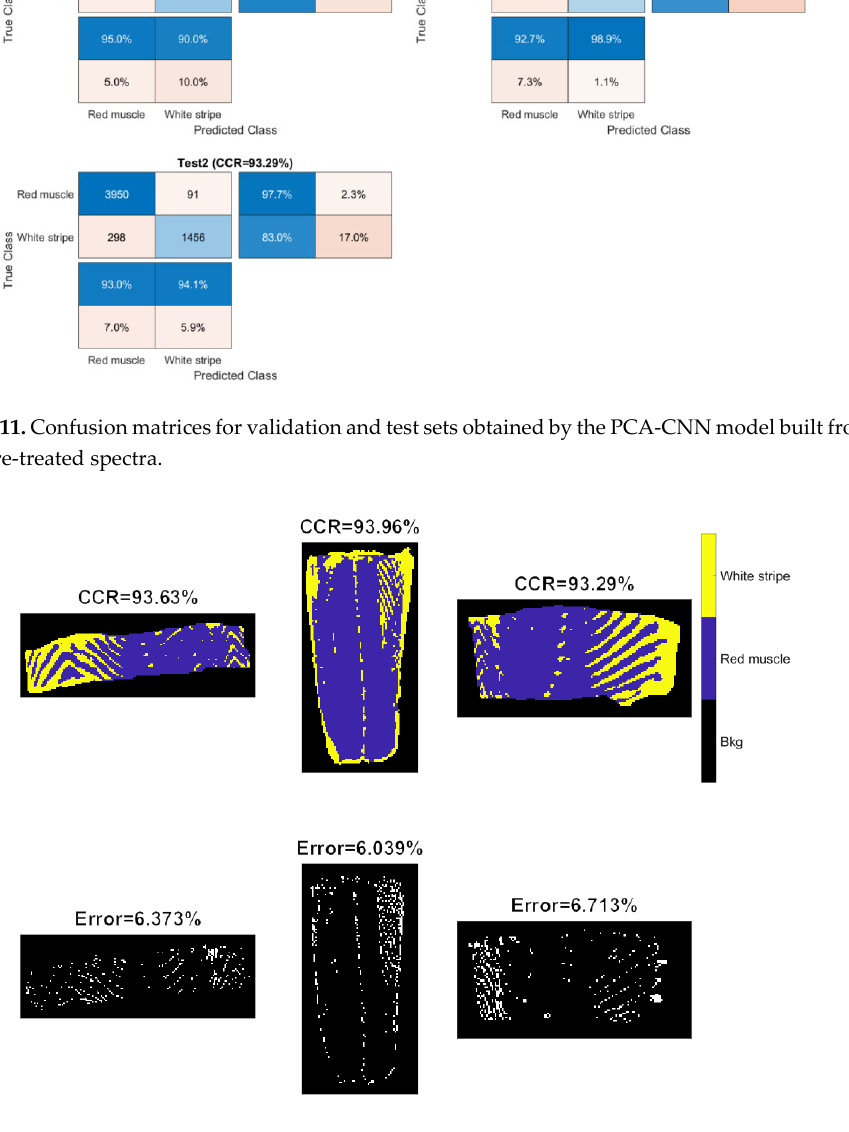
Figure 12. Classification and misclassification maps for validation (the left image) and test sets (the middle and right images) obtained by the PCA ‐ CNN model built from EPO pre ‐ treated